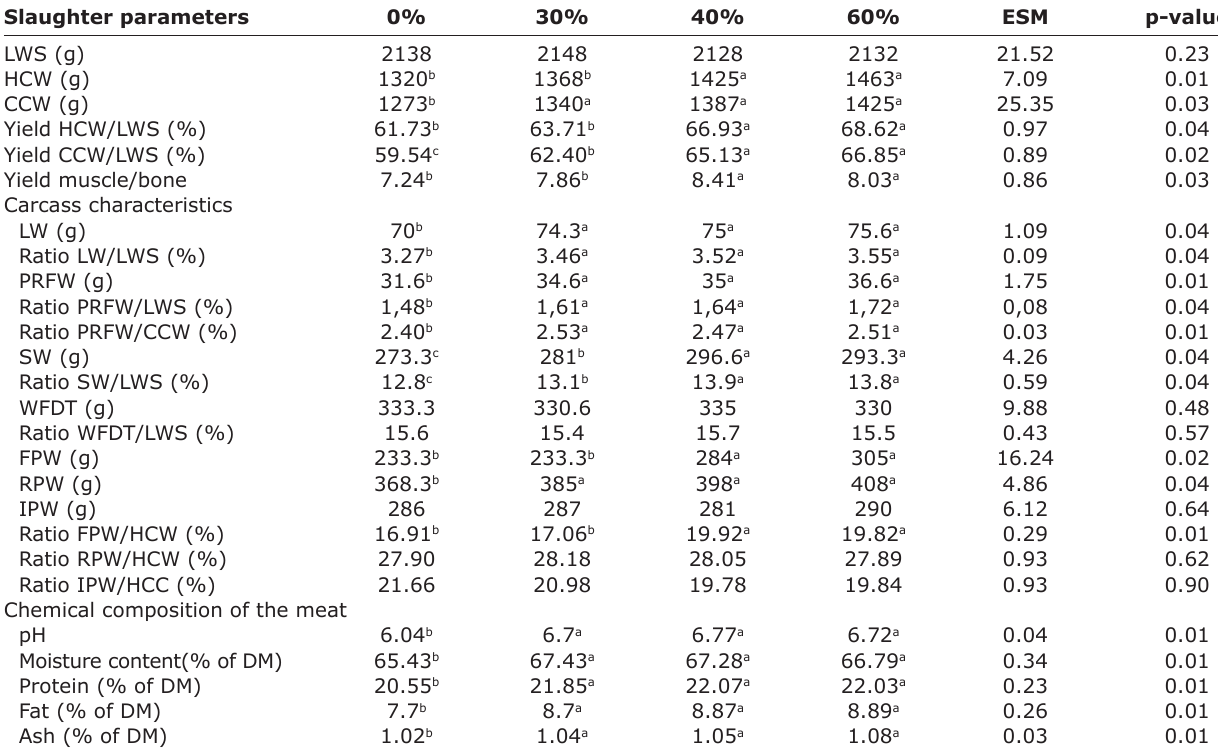
Table-6: Evolution of slaughter parameters and carcass characteristics of young rabbits at fattening according to the percentage of incorporation of the complex apricot kernel cake and tomato pulp. Slaughter parameters